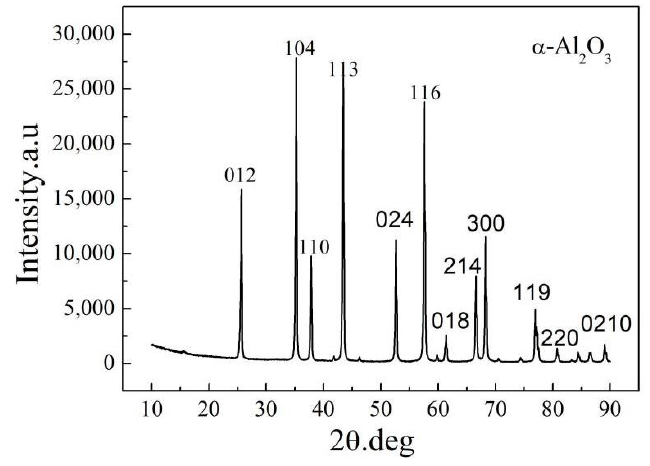
Figure 2. XRD pattern of as-received Al 2 O 3 nanoparticles. Table 1. Experimental scheme of the rheoformed 2024 aluminum matrix composite reinforced by Al 2 O 3 nanoparticles and original 2024 components.